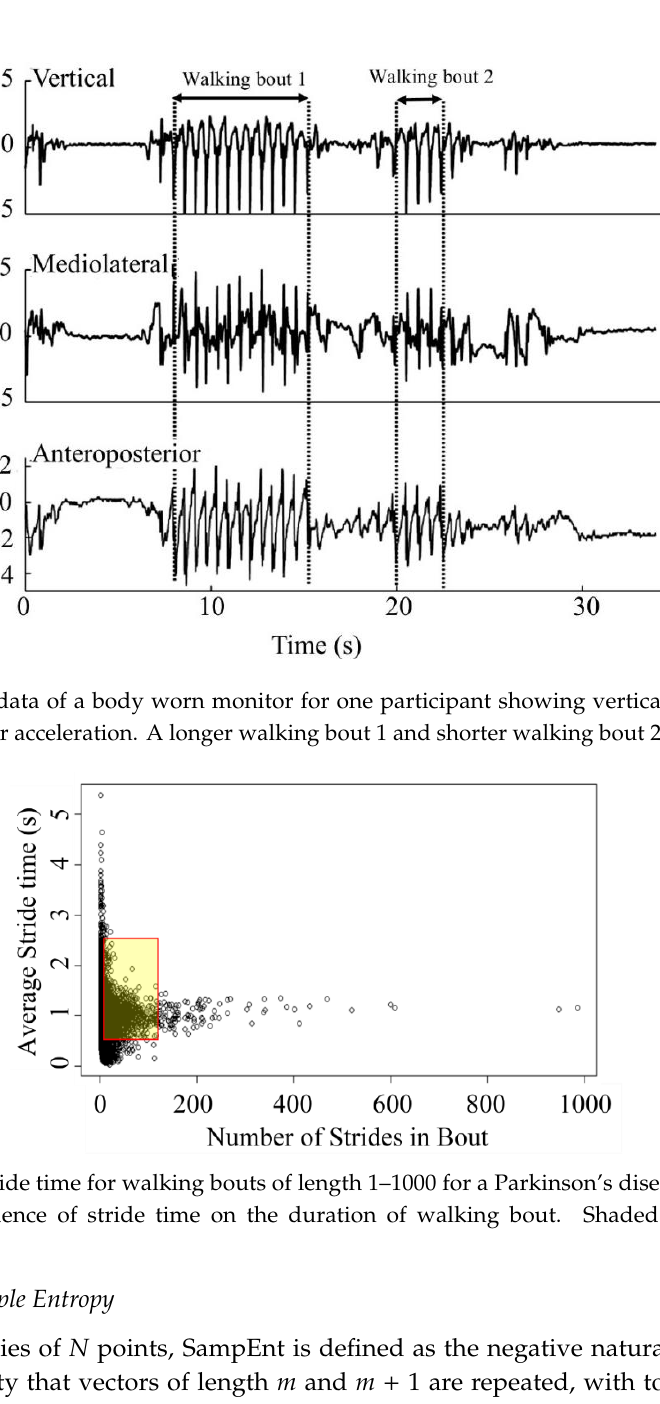
Figure 3. Mean stride time for walking bouts of length 1 – 1000 for a Parkinson’s disease participant, indicating dependence of stride time on the duration of walking bout. Shaded area indicates included bouts.